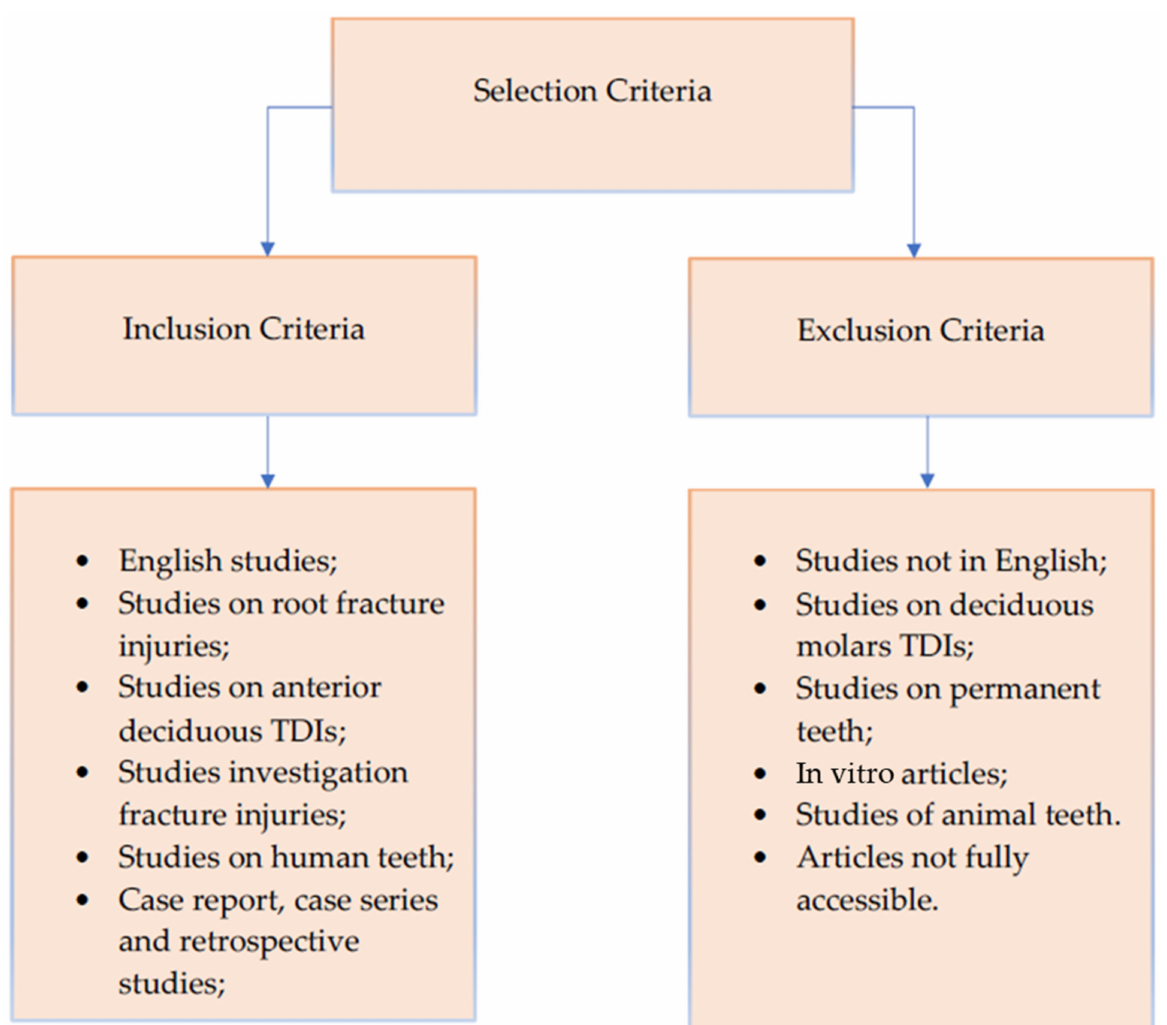
Figure 1. Diagram showing the inclusion and exclusion criteria used for this